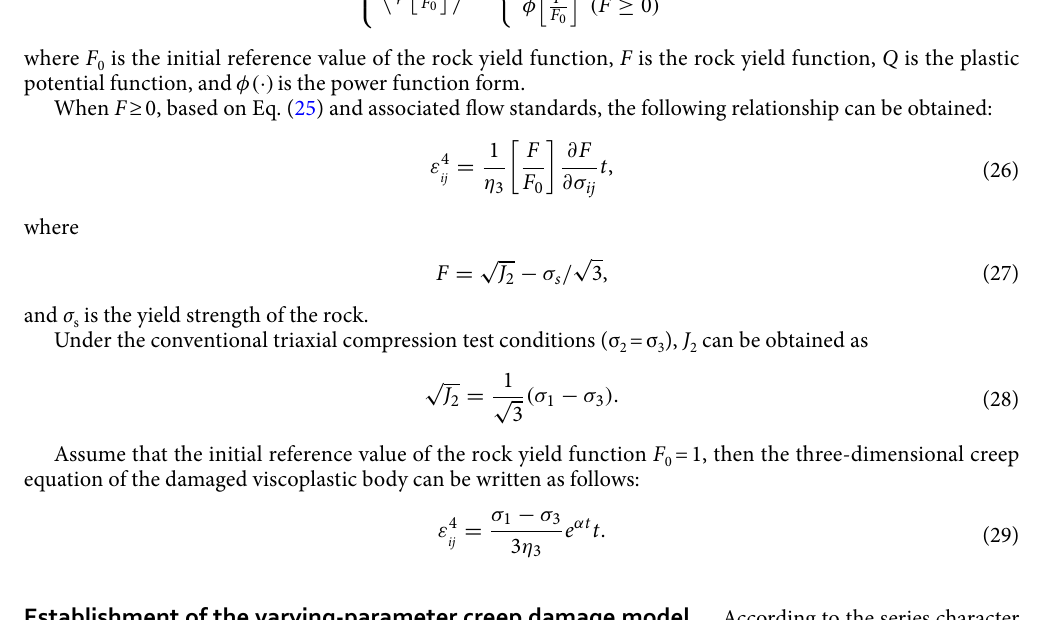
of components, the following relationship can be